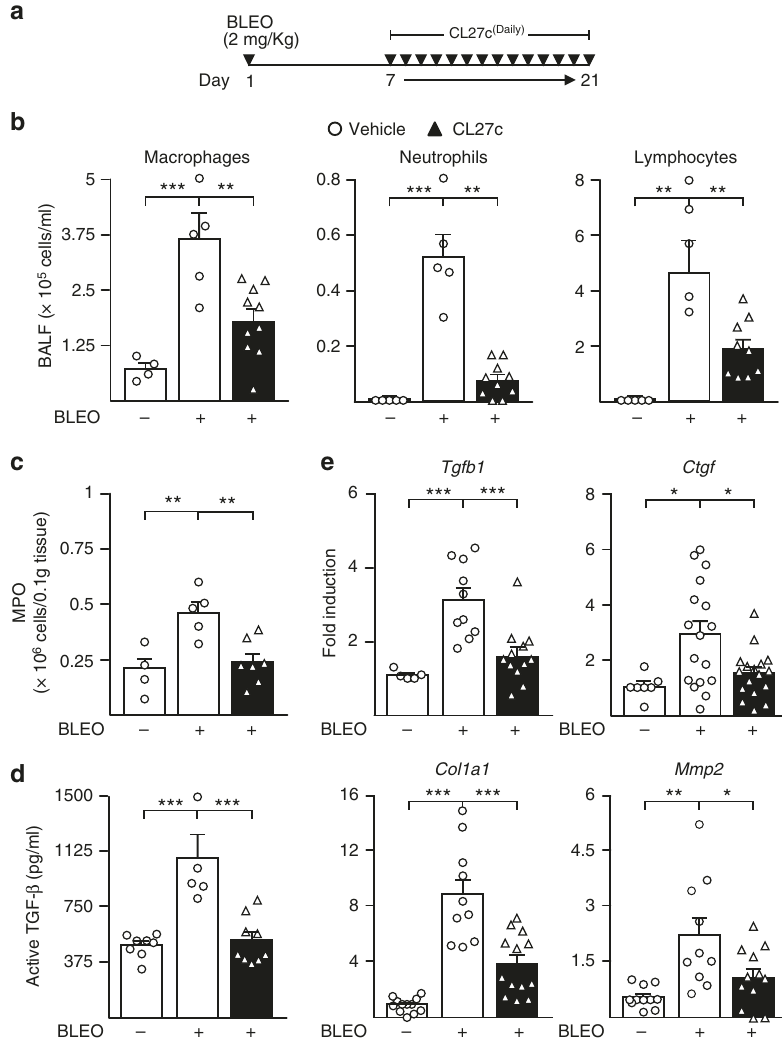
Fig. 6 Reduced in fl ammation and expression of fi brotic markers after CL27c inhalation in a moderate protocol of bleomycin-induced lung fi brosis. a Protocol for Bleomycin-induced lung injury, elicited by intranasal instillation of 2 mg/kg Bleomycin (Bleo), and treatment regimen with aerosolized CL27c (2 mg/ml). b Quanti fi cation of macrophages, neutrophils, and lymphocytes content in BALF in control and CL27c-treated mice (from left to right macrophages n = 4, 5, 10, neutrophils n = 5, 5, 10, and lymphocytes n = 5, 5, 9 independent experiments, respectively). c Analysis of myeloperoxidase (MPO) expression in the lungs of control and CL27c-treated mice (from left to right n = 4, 5, 7 independent experiments, respectively). d Measurement of active levels of TGF- β with or without CL27c inhalation (from left to right n = 8, 5, 9 independent experiments, respectively). e Quanti fi cation of the expression of selected pro- fi brotic genes, including transforming growth factor- β ( Tgfb1 ), connective tissue growth factor ( Ctgf ), collagen type-1 ( Col1a1 ), and matrix metalloproteinase-2 ( Mmp2 ) (from left to right, Tgfb1 n = 5, 10, 12, Ctgf n = 7, 17, 17, Colla1 n = 12, 10, 13, and Mmp2 n = 11, 10, 12 independent experiments, respectively). Results represent mean ± s.e.m., * P < 0.05, ** P < 0.01, *** P < 0.001 determined using one-way ANOVA followed by